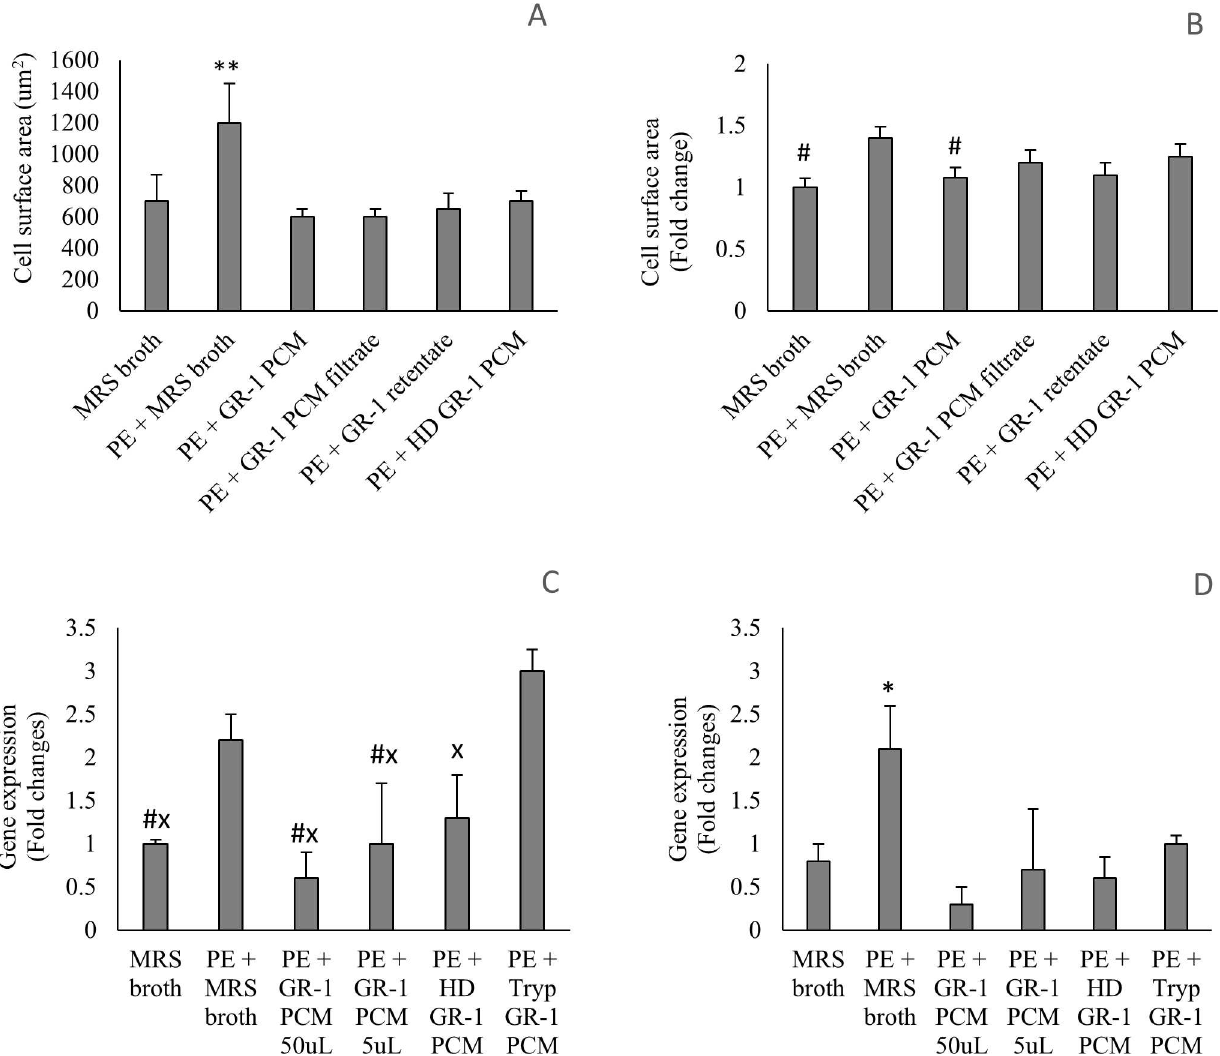
Fig 5. PCM inhibits the PE-induced hypertrophy in NVCM. A . NVCM surface area following24 hour co-culture with various PCM treatments (n = 5). B : The fold changein NVCM surface area comparedto untreatedcells, following24 hour co-culture with variousPCM treatments (n = 5). C, D : The fold changein gene expressionof ANP (C) and aSKA (D) compared to untreatedNVCM after 24 hour co-culture with variousPCM treatments (n = 3). Unlessotherwisestated, all PCM volumes were 50 μ L. * P < 0.05 and ** P < 0.01 comparedto all other treatments . # P < 0.05 comparedto PE + MRS broth. × P < 0.05 comparedto PE + Tryp GR-1 PCM. Error bars indicatethe standard deviation. HD denotes heat